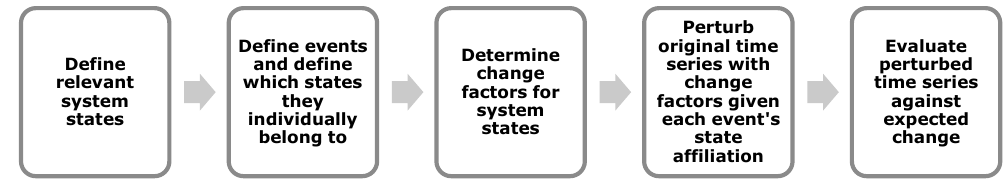
Figure 1. Flow diagram showing the general process involved in the presented methodology.